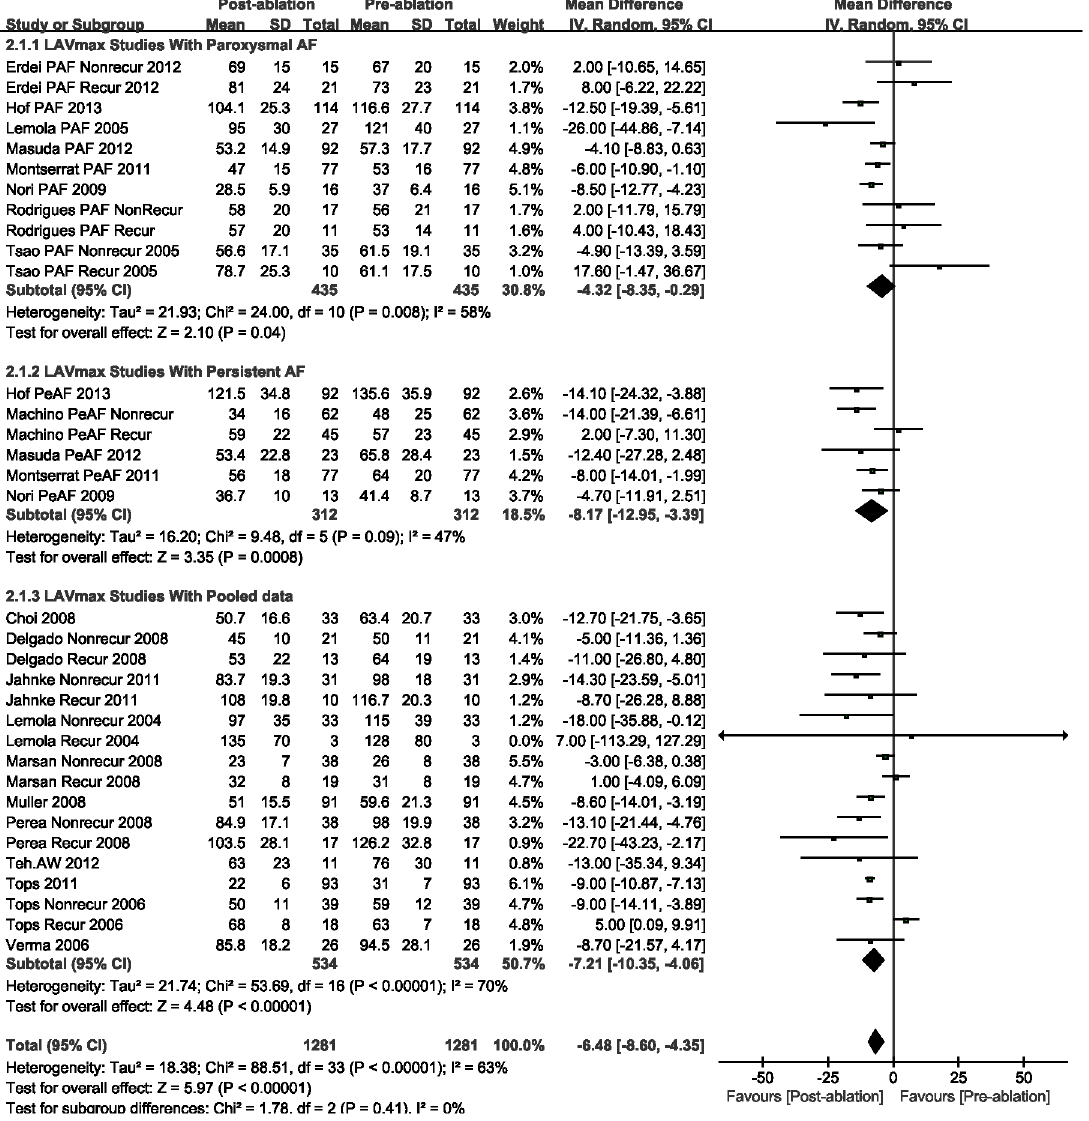
Fig 3. A forest plot of comparison: changes in maximum left atrial volume (LAVmax) pre-ablation and